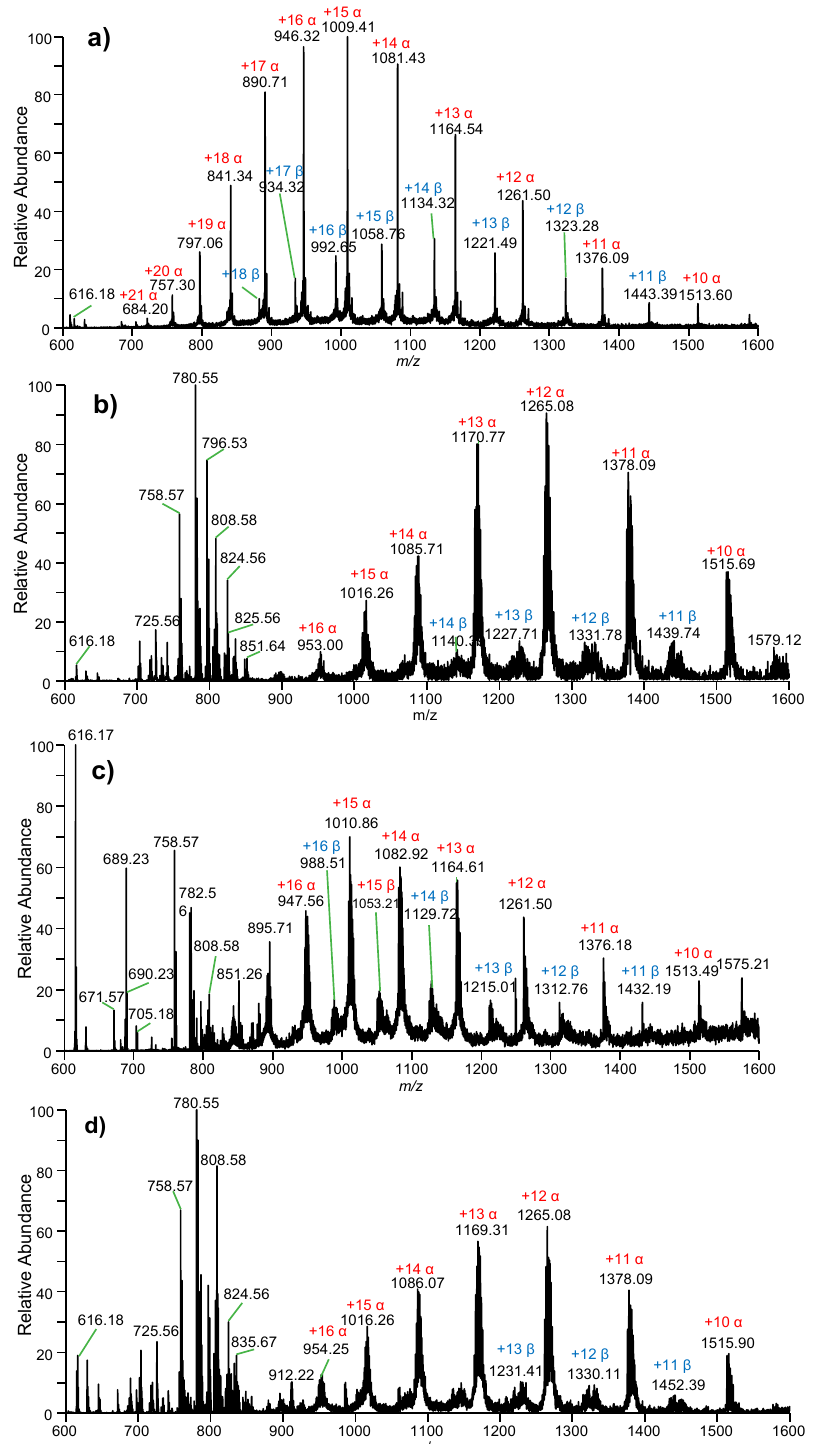
Figure 2. Mass spectra obtained by ESI ‐ MS for the direct detection of human Hb from: ( a ) conven ‐ tional ESI spectrum of pure Hb standard, ( b ) WT ‐ ESI spectrum of healthy whole blood, ( c ) WT ‐ ESI spectrum of α‐ thalassemia whole blood, and ( d ) WT ‐ ESI spectrum of β‐ thalassemia whole blood. In particular, it is important to note that the peaks of protein ions from raw blood samples are wider than those obtained from Hb standard, probably because Hb chains